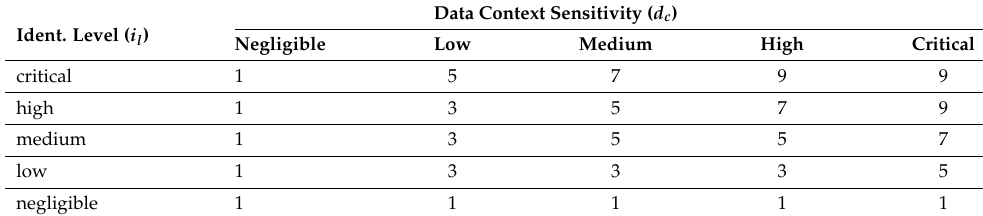
Table 5. An example of a decision matrix for calculating the privacy attack impact ( α i